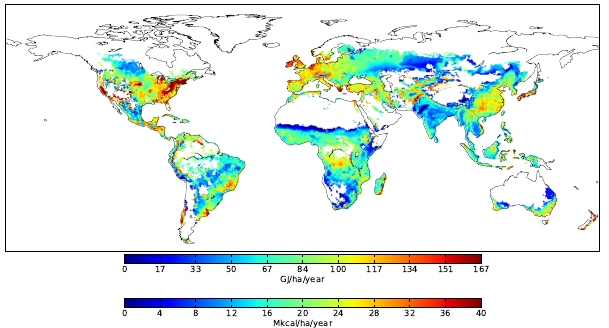
Fig. 4. Representative potential yield of crops modelled in the LPJmL model (dynamic crops), average over the 1999–2003 pe- riod. CFT fractions of cells). These representative potentials yields must be interpreted as the maximum achievable yield on a grid cell assuming the CFT fractional coverage around the year 2000, and not as the maximum achievable yield on a grid cell assuming 100 % coverage by the most productive